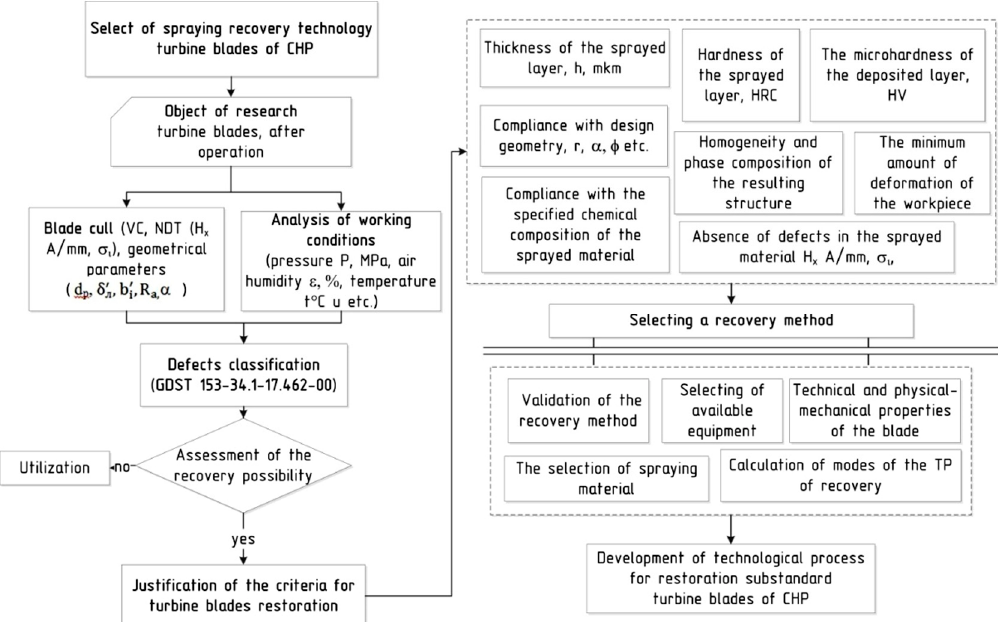
Figure 1. Algorithm for the choice of turbine blade recovery technology: d р —diameter, area with erosion-corrosion changes, mm; δ (cid:48) —profile thickness, in the area with erosion-corrosion changes, mm; b (cid:48) —blade profile depth in the area with erosion-corrosion changes, mm; R a —surface roughness of the area with erosion-corrosion changes, µ m. Coatings 2020 , 10 , x FOR PEER REVIEW 6 of 14